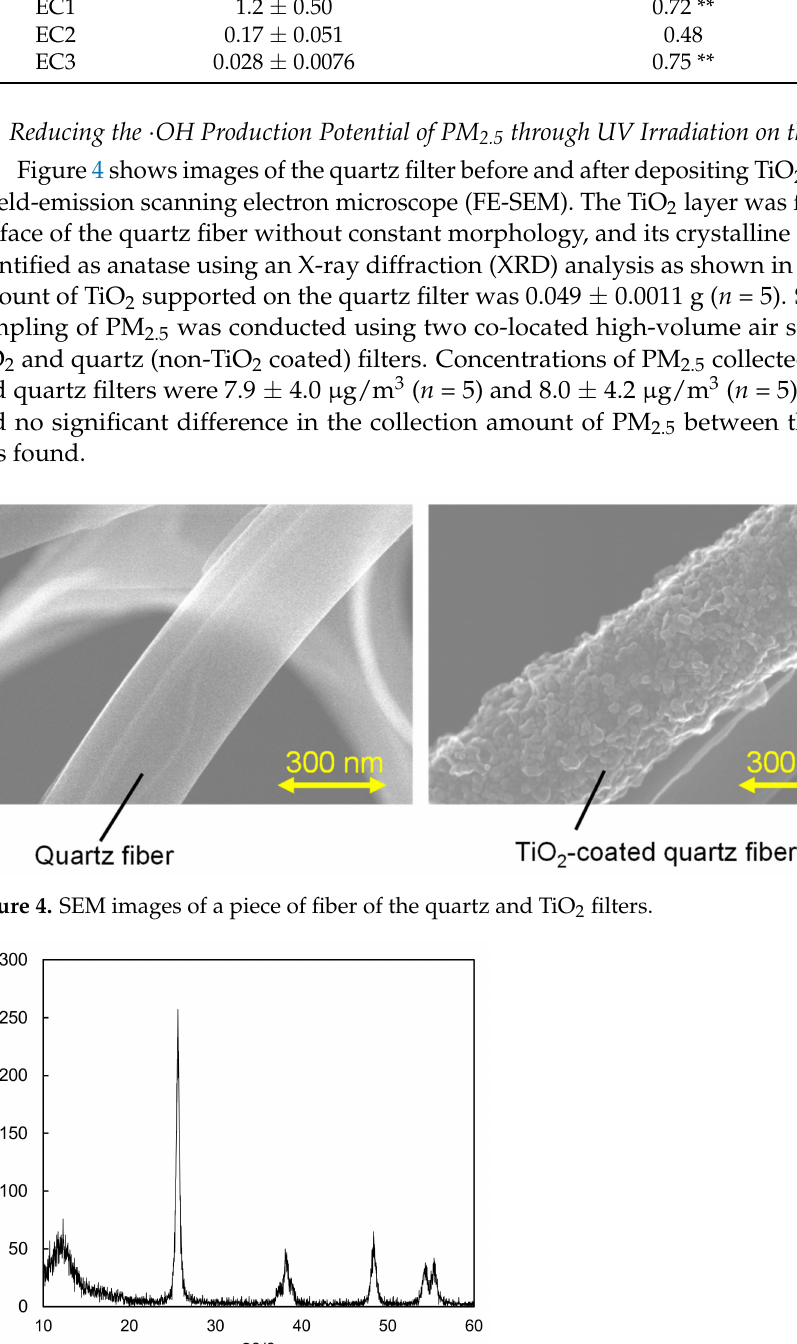
Table 2. Concentrations of the carbonaceous components collected on the quartz filter ( µ g/m 3 ) and Pearson’s correlation coefficient ( r ) between atmospheric concentrations and · OH production potentials of the seven fractions. * p < 0.01, ** p < 0.05. Pearson’s Correlation Coefficient between Fraction Concentration ( µ g/m 3 ) Concentration and · OH Production Potential ( r ) OC1 0.063 ± 0.014